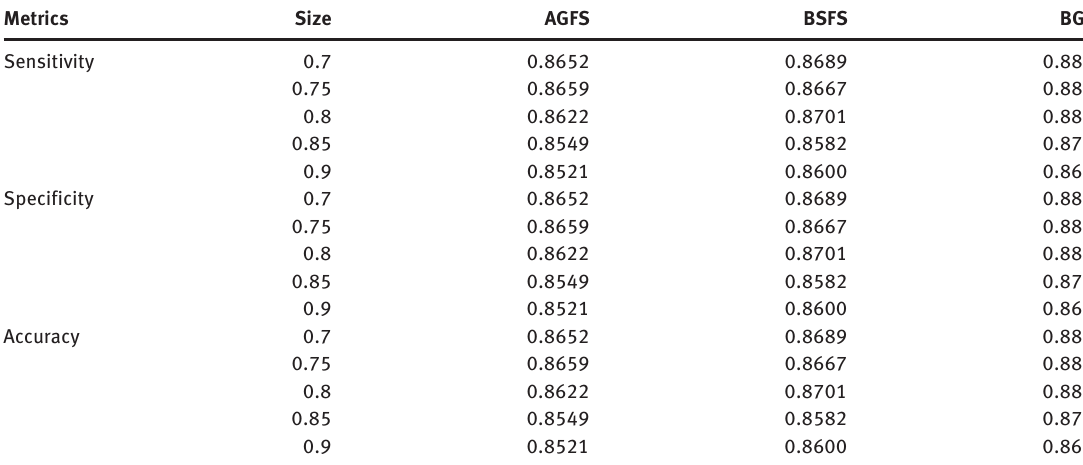
Table 3: Comparison on